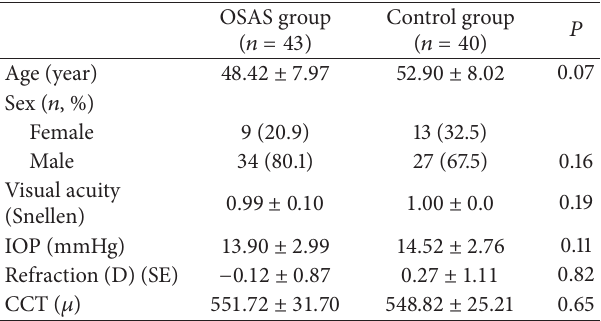
Table 1: Demographic characteristics of obstructive sleep apnea syndrome (OSAS) and control groups.